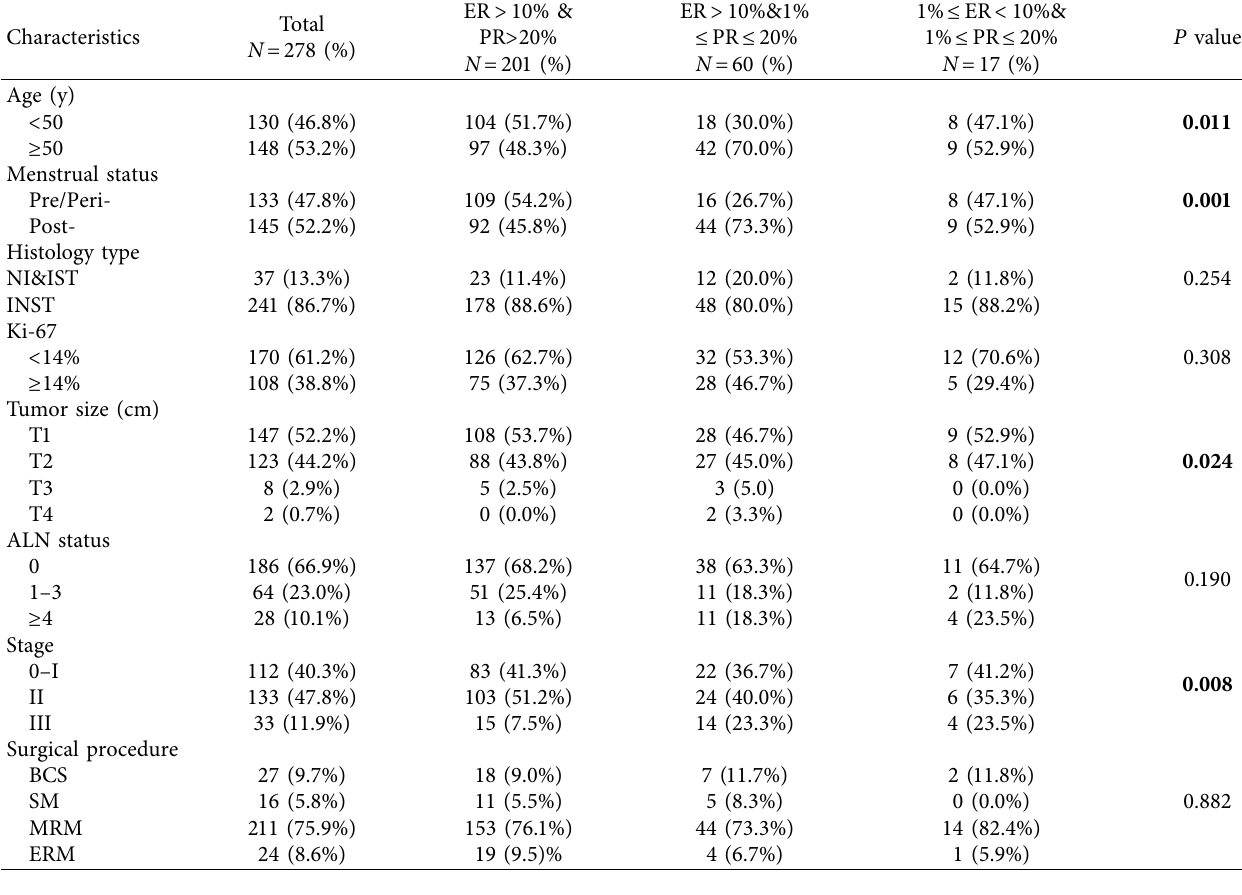
Table 2: Tumor and patient characteristics stratifed by ER and PR statue.